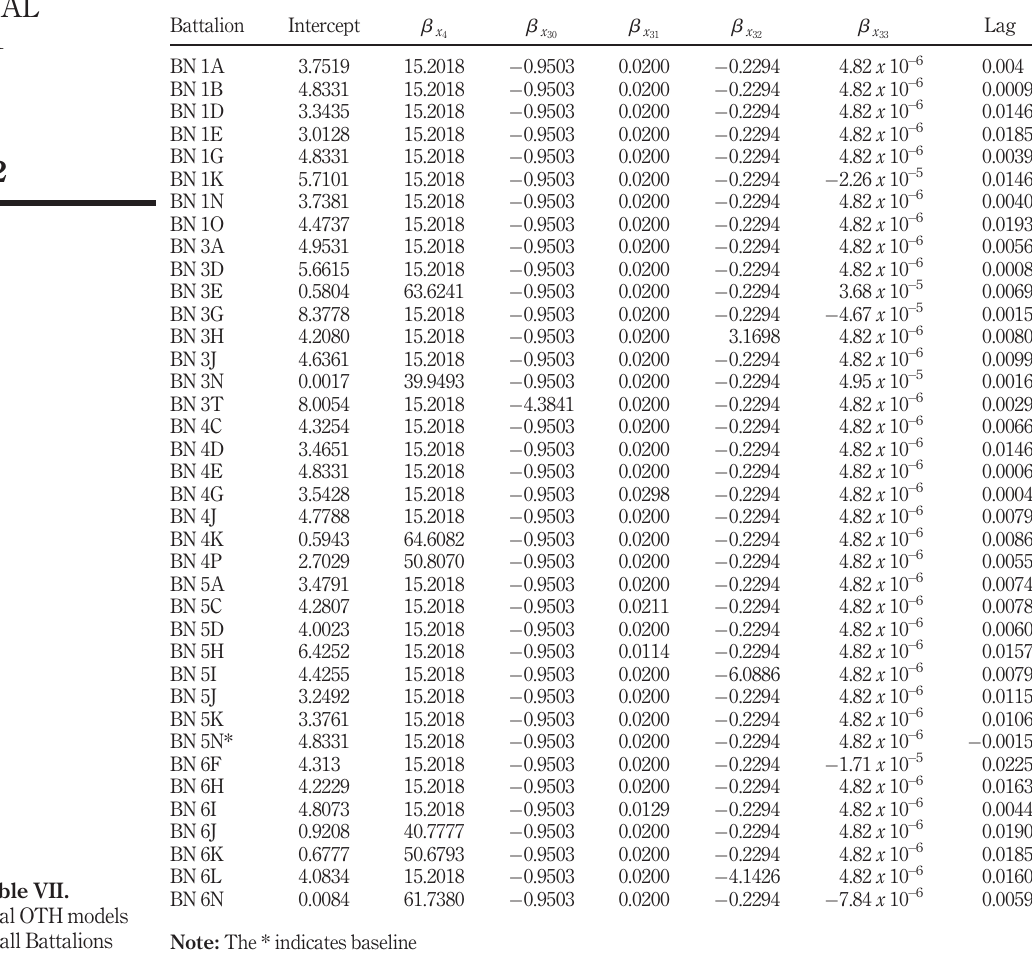
Table VII. Final OTH models for all